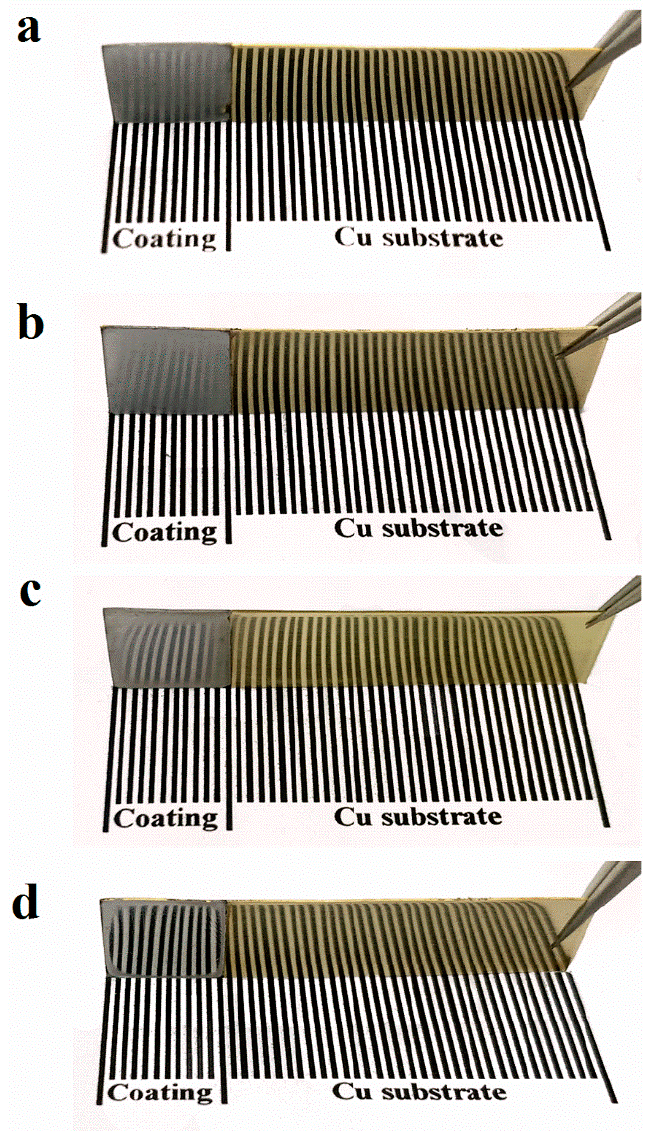
Figure 5. Photographs of the ( a ) Al-Mn-BK, ( b ) Al-Mn-HP, ( c ) Al-Mn-PA and ( d ) Al-Mn-CP coatings reflection stripes.